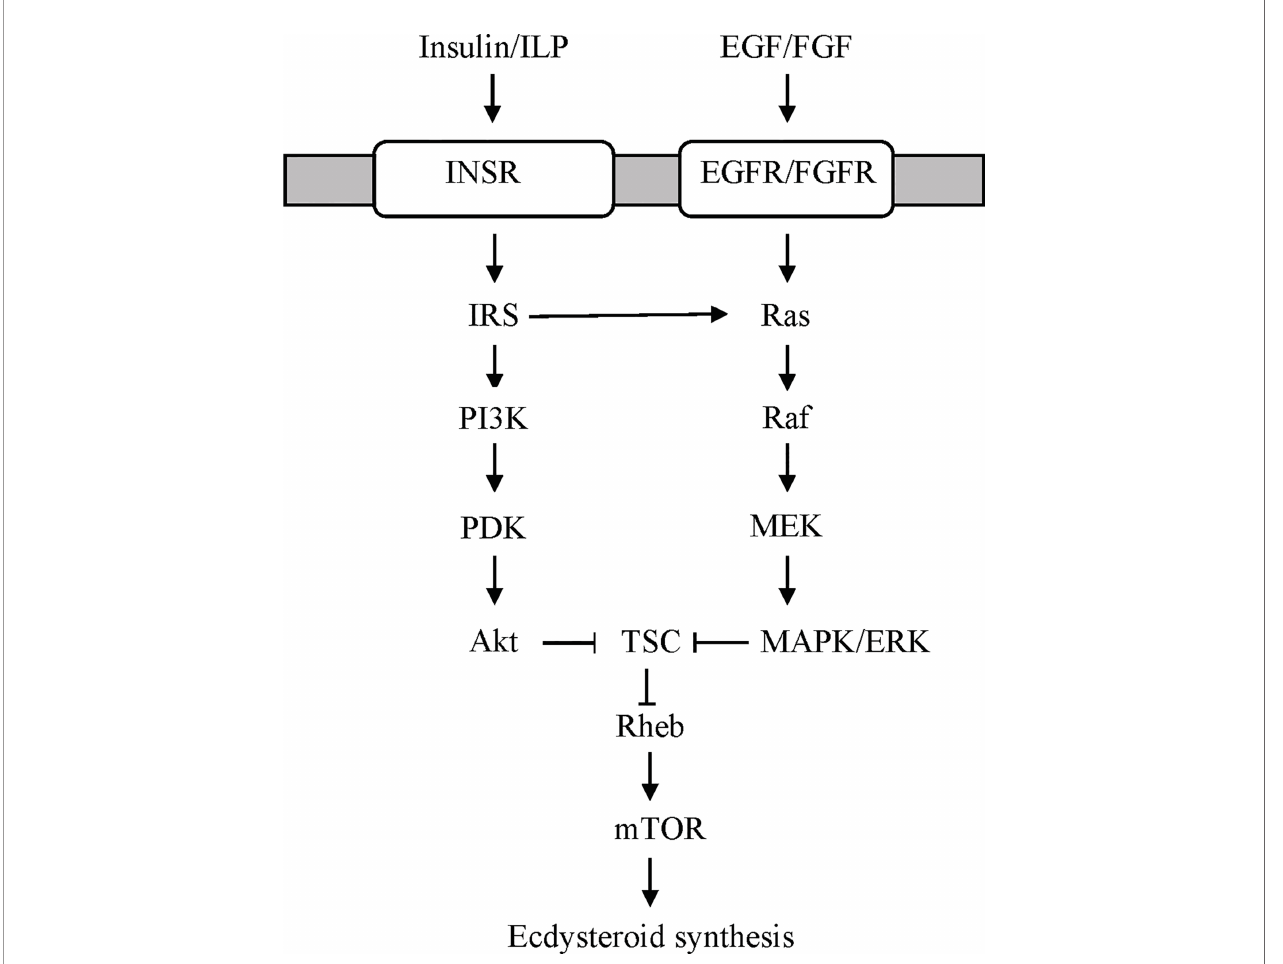
FIGURE 4 | Proposed receptor tyrosine kinase (RTK)-mediated signaling pathways stimulating ecdysteroidogenesis in the YO based on data from the insect prothoracic gland (97, 98). YOs express both types of RTKs ( Table 3 ). Growth factors, such as epidermal growth factor (EGF) or fi broblast growth factor (FGF), bind to EGF or FGF receptors, respectively, to activate the Ras/Raf/MEK/ERK signaling pathway. Insulin/insulin-like peptide (ILP) binds to insulin receptor (INSR) to activate PI3K/PDK/Akt and/or Ras/Raf/MEK/ERK signaling. Both pathways converge on mTOR signaling by phosphorylation of tuberous sclerosis complex (TSC) by Akt or ERK, respectively. ERK, extracellular signal-regulated kinase; IRS, insulin receptor substrate; MEK, MAPK/ERK kinase; PDK, protein 3-phosphoinositide- dependent protein kinase; PI3K, phosphoinositide 3-kinase